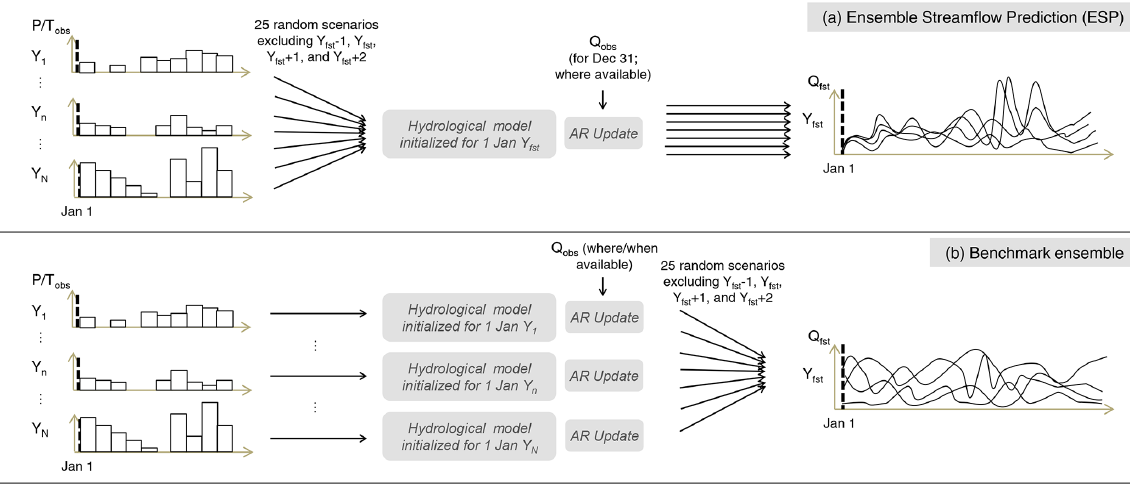
Figure 2. Schematic of the forecast generation procedure in this study: (a) ESP re-forecasts and (b) benchmark forecasts. Adapted from Crochemore et al.